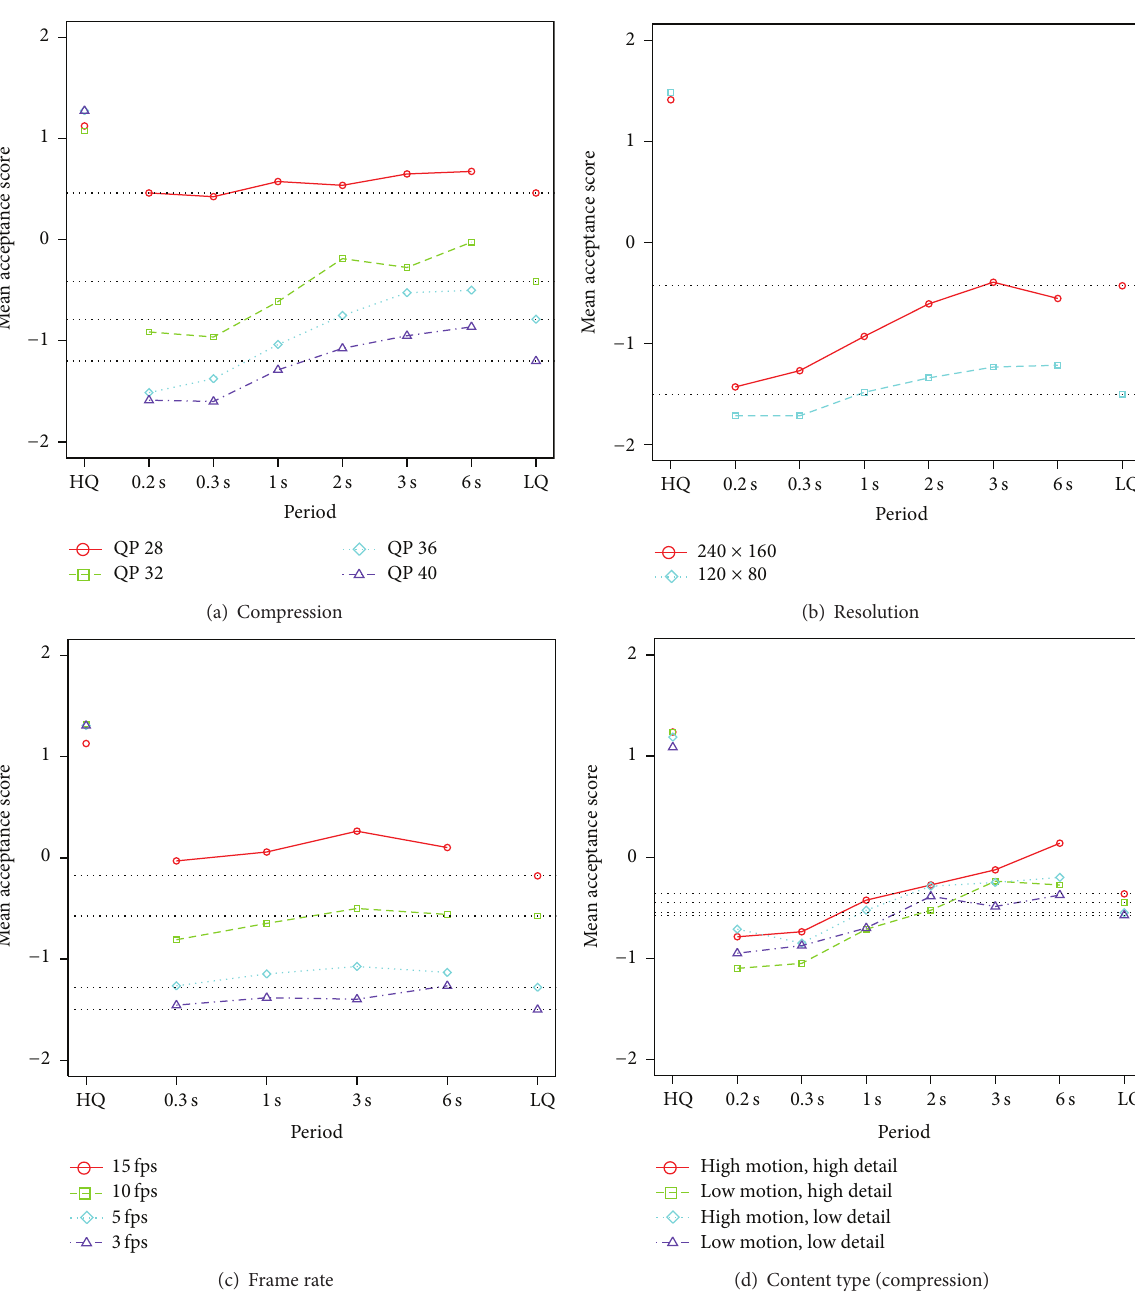
Figure 11: Mean acceptance scores for adaptation frequencies using (a) compression, (b) resolution, and (c) frame rate adaptation. (d) shows the impact of content type for the compression